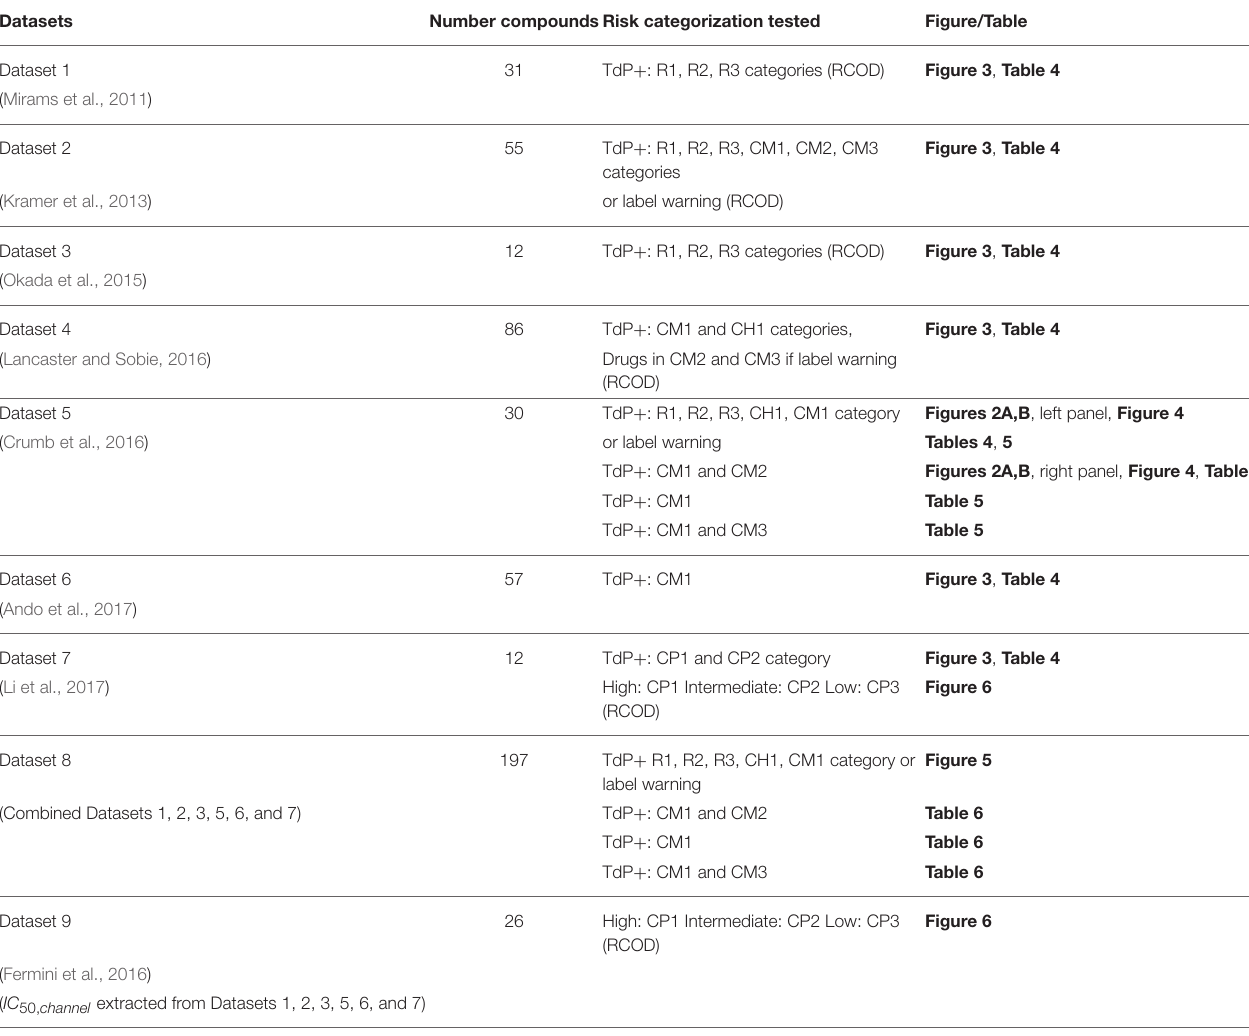
TABLE 2 | Datasets analyzed for TdP risk. The total number of drugs in each dataset is listed in the “Number compounds” column.